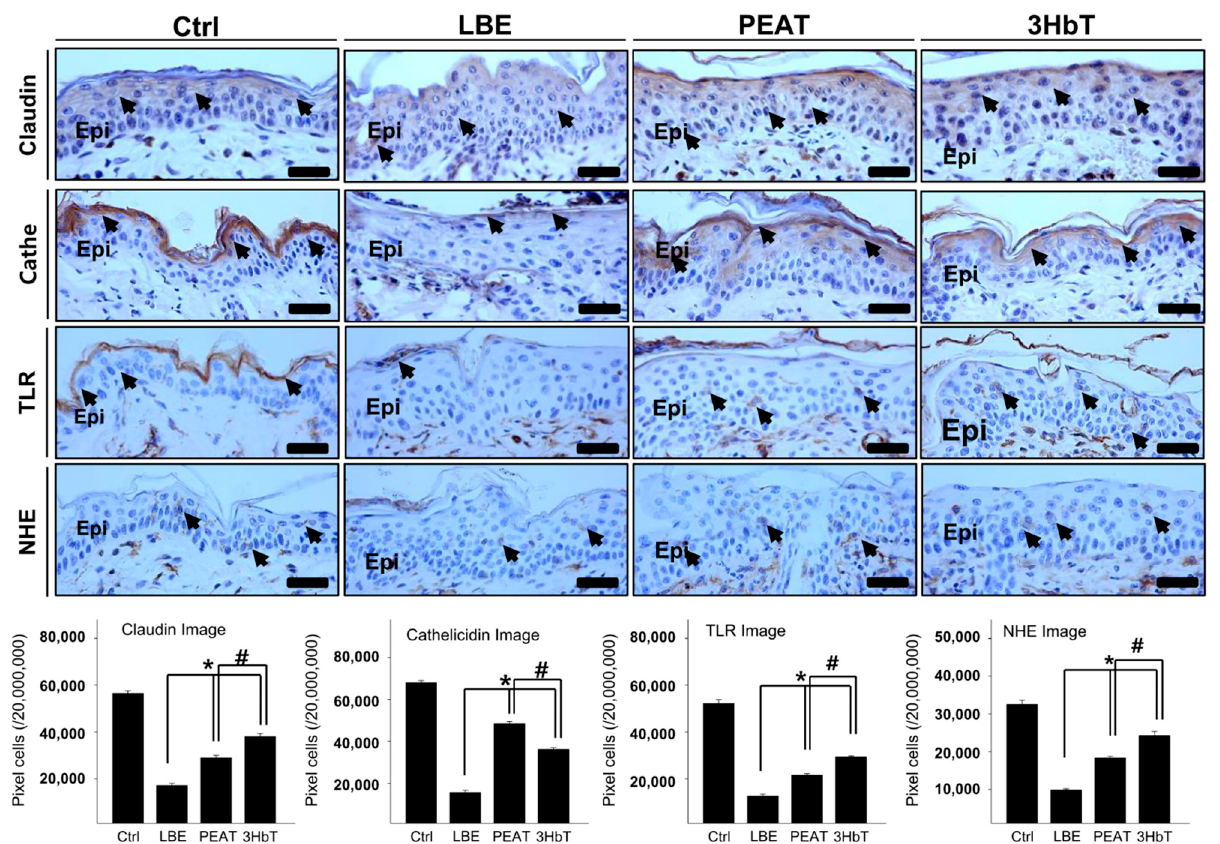
Figure 6. The regulation of the skin micro-environment for defense using Three Herb (3Hb) extract. The expression of claudin, cathelicidin, TLR, NHE (light brown particles indicated by arrows) was significantly lower in 3HbT compared to PEAT and LBE (immunohistochemistry; bar size, 50 µm). The data of image analysis for a positive reaction showed the same results. 3Hb, Rhizome of Coptis chinensis , Rhizome of Glycyrrhiza uralensis , and fermented Semen of Glycine max ; Ctrl, the normal group; LBE, lipid barrier elimination group; 3HbT, 3Hb treated group after lipid barrier elimination; Cathe, cathelicidin; TLR, toll-like receptor; NHE, sodium hydrogen antiporter; Epi, epidermis; * p < 0.05 compared to LBE; # p < 0.05 compared to PEAT.